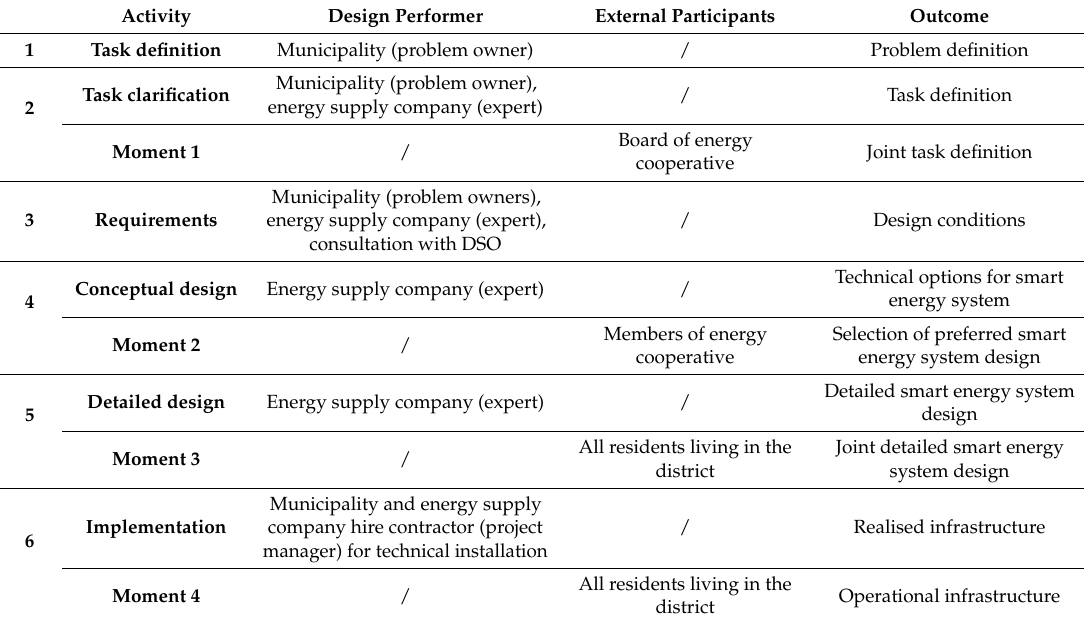
Table 3. The decision-making model applied to a specific